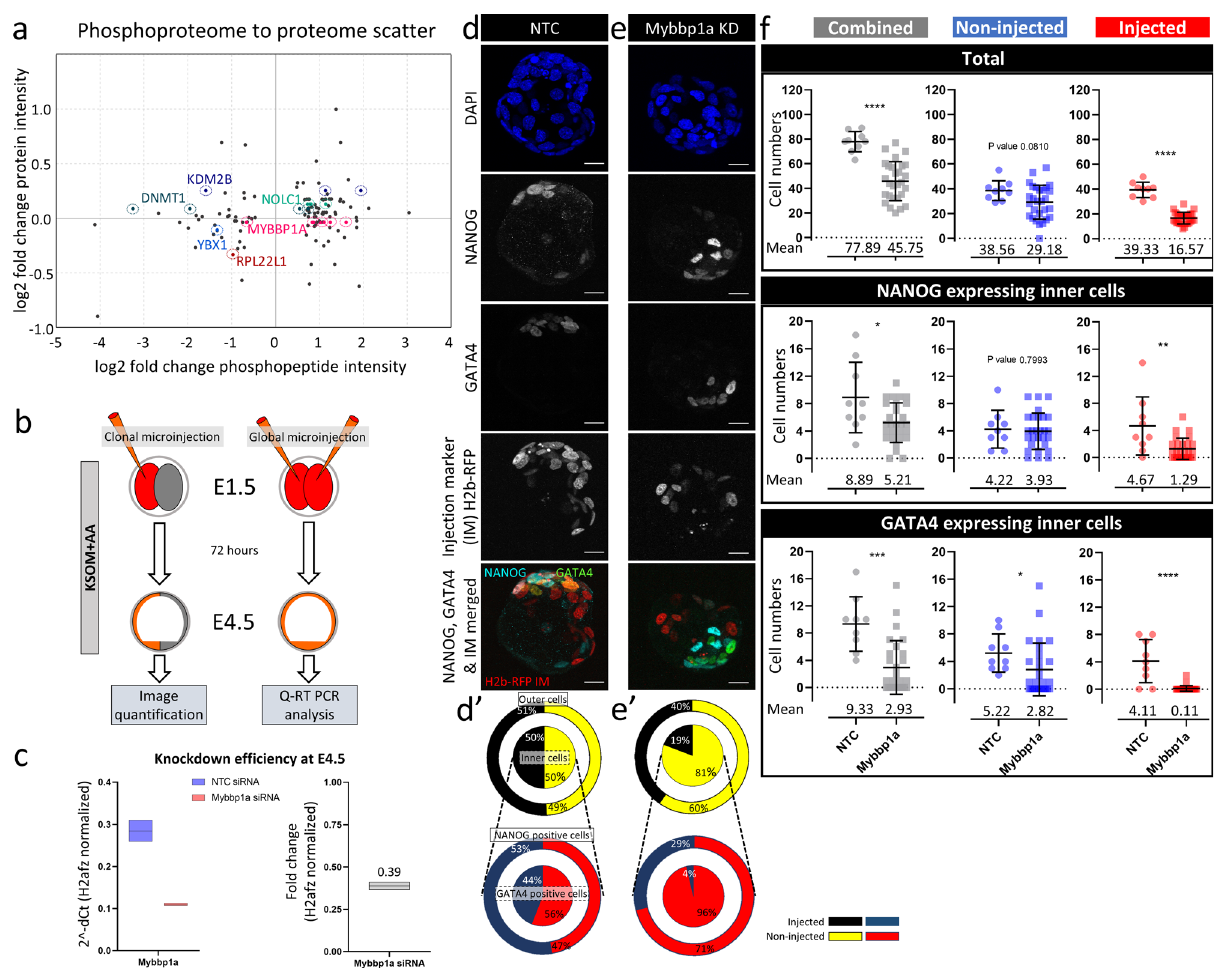
Fig. 6 Analysis of the role of MYBBP1A (a candidate target of p38-MAPK activity) in preimplantation embryonic development and ICM cell fate speci fi cation. a Phosphoproteome-to-proteome scatterplot for MS-detected peptides demonstrating <1.3-fold differences in abundance in the general proteome and >1.5-fold changes in phosphorylation levels. Candidates of interest (based on literature research; e.g., MYBBP1A), are highlighted (and were assayed for PrE phenotypes in clonal siRNA microinjection-mediated loss-of-function assays — c – f , Supplementary Fig. 4, and Supplementary Data 2). b Experimental design for analysis of the ef fi ciency of siRNA-mediated Mybbp1a gene mRNA knockdown in microinjected embryos cultured to the equivalent late blastocyst (E4.5) stage (qRT-PCR analysis) and for analysis of the contributions of marked Mybbp1a -knockdown clones to late blastocyst cell lineages (Lineage quanti fi cation). c Comparison of qRT-PCR-derived relative Mybbp1a transcript levels (normalized to H2afz mRNA levels) between embryos injected with non-targeting control (NTC) siRNA and embryos injected with siRNA speci fi c for Mybbp1a mRNA. Mybbp1a expression levels between control (blue) and Mybbp1a speci fi c siRNA (red) injected embryos expressed as box plots, alongside fold-change. d Confocal micrograph z- projections of representative late (E4.5)-stage blastocysts initially microinjected (in one blastomere at the 2-cell stage) with NTC siRNA ( n = 9) plus recombinant H2b-RFP fl uorescent reporter mRNA (identifying the clonal progeny of the injected cell). Individual DAPI (blue pan-nuclear stain; indicates the total number of cells), NANOG (grayscale; EPI cells) and GATA4 (grayscale; PrE cells) channel micrographs, plus merged NANOG (cyan), GATA4 (green), and H2B-RFP (microinjected clone) images, are shown (scale bar = 20 μ m). d ′ Target diagrams describing the average percentage contributions of NTC siRNA-microinjected and non-microinjected clones to either outer and inner cell populations (black and yellow targets) or mutually exclusive NANOG- and GATA4-expressing ICM cell lineages (red and blue targets). e Similar to d . e ′ is similar to d ′ , but the results were obtained after microinjection of Mybbpa1 - speci fi c siRNA ( n = 28). f Scatterplots describing the contributions of non-microinjected (blue) and microinjected (red) cell clones (plus the combined number — gray) of NTC/ Mybbp1a siRNA-treated embryos to the total cell count, number of inner cells expressing NANOG only, and number of inner cells expressing GATA4 only. The means and standard deviations are